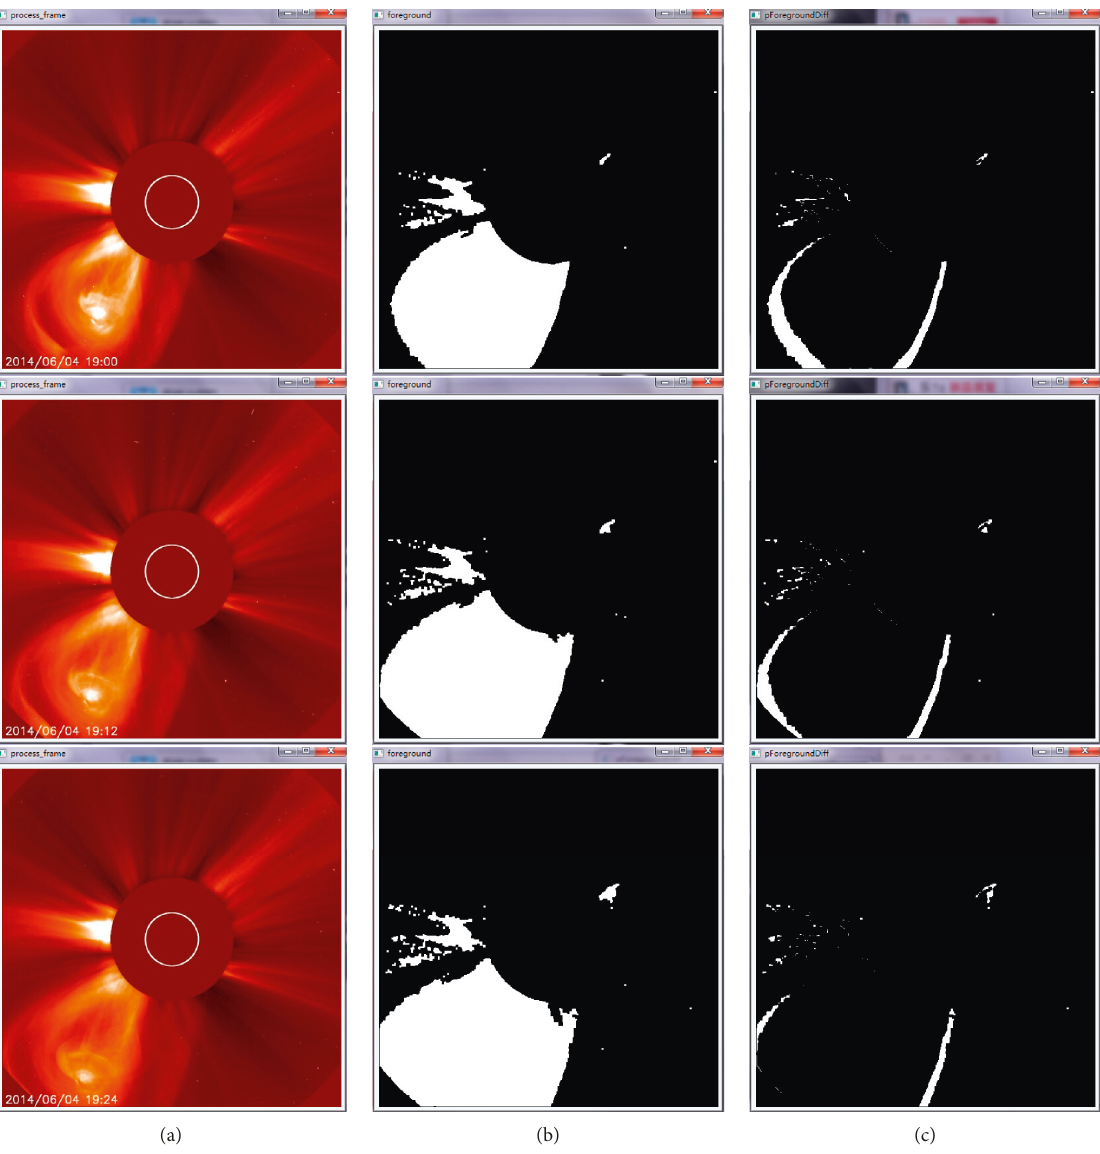
Figure 6: A poor CME event (appearance date-time (UT): 2014/06/0419 :00: 05) detected by the adaptive background learning method. (a) LASCO C2 pseudocolor coronagraph images; (b) the candidate CME area images; (c) the increasing region images of the candidate CME